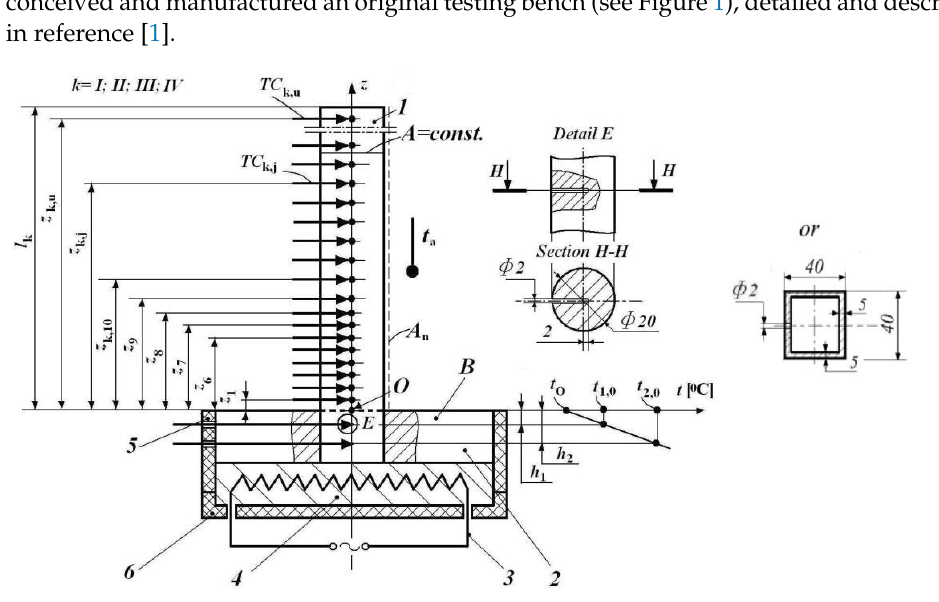
Figure 1. The principle schema of the original testing bench with completions [1].